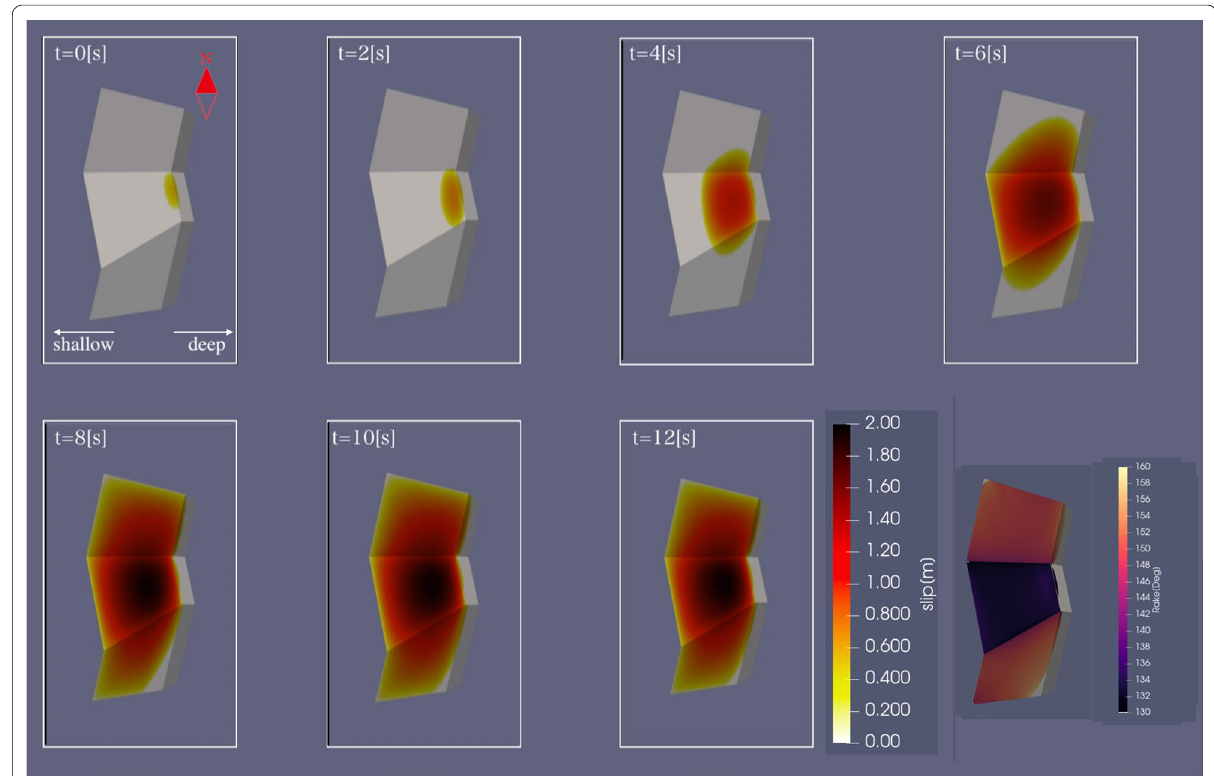
Fig. 7 Snapshots of slip history obtained by the simulation for Model 5 at every 2 s from 0 to 12 s. View from the top. White rectangles correspond to the area shown in Fig. 5 (inset) rake angle distribution for the final